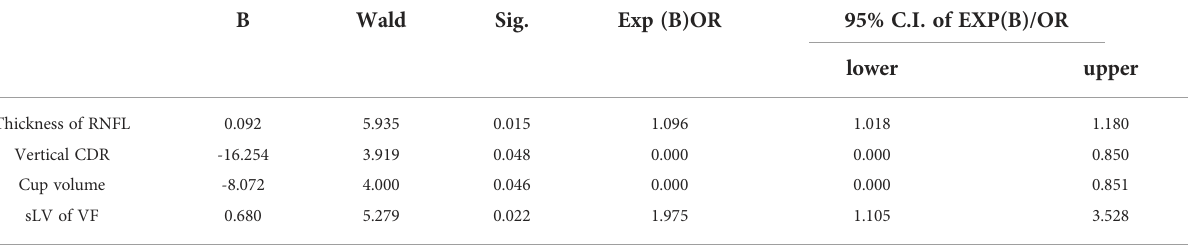
TABLE 4 The in fl uence of VF and RNFL on the diagnosis with the binary logistic regression. B Wald Sig. Exp (B)OR